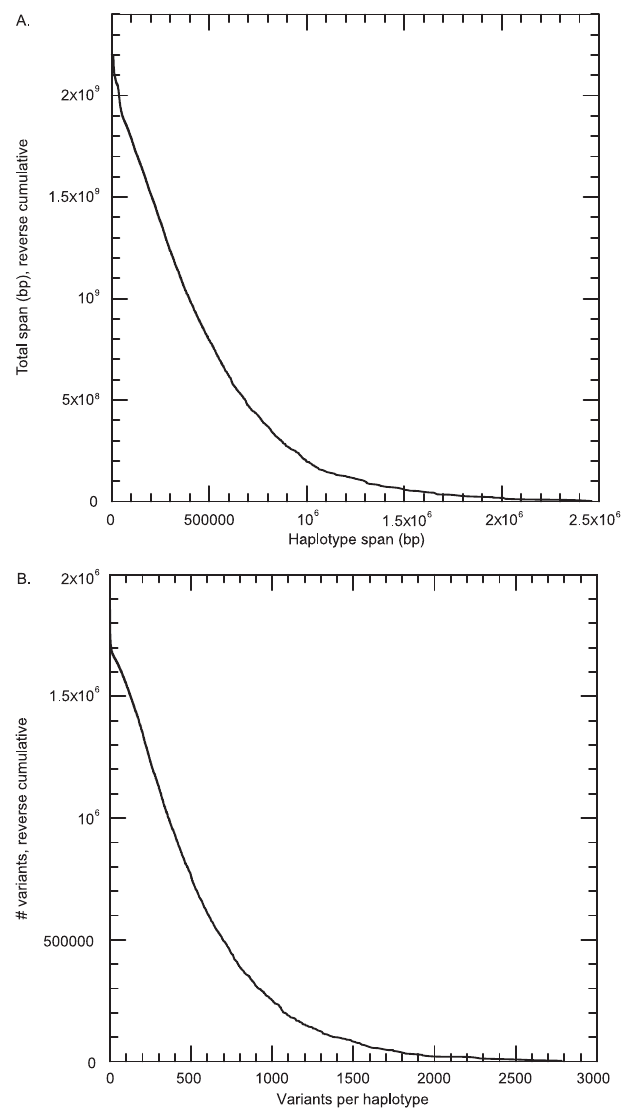
Figure 12. Distribution of Inferred Haplotype Sizes (A) Reverse cumulative distribution of haplotype spans (bp) (N50 ; 350 kb). (B) Reverse cumulative distribution of variants per haplotype (N50 ; 400 variants).